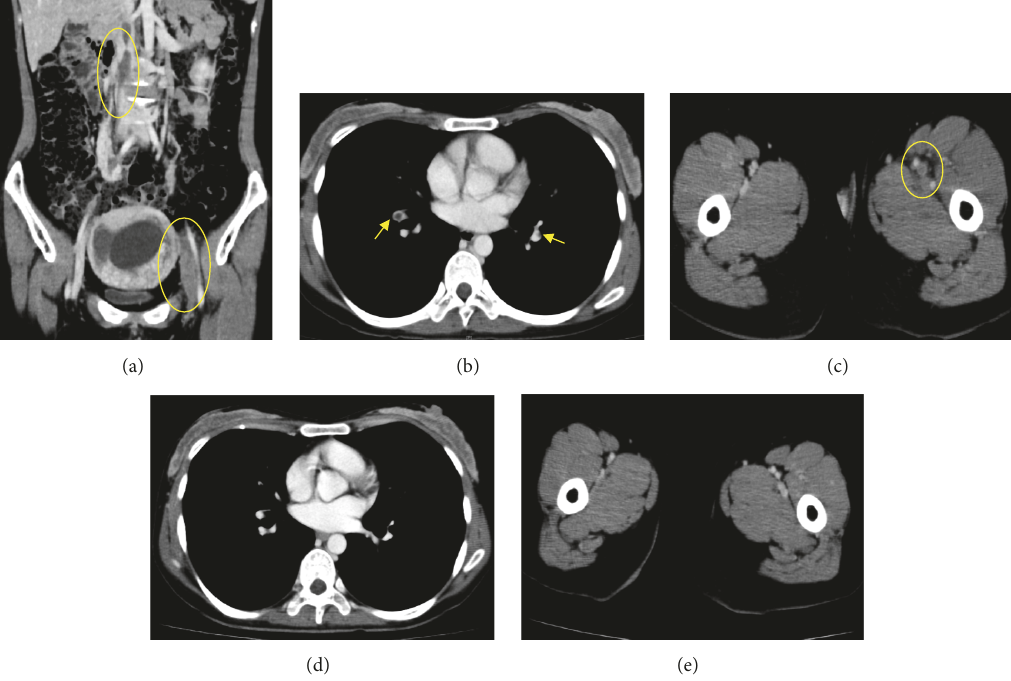
Figure 1: Development of severe VTE, and its disappearance after treatment at patient’s fourth pregnancy. (a ∼ c) Contrast CT image taken at the admission day. (a) Coronal plane, large thrombosis exists in inferior vena cava and femoral vein. (b) Transverse plane at the level of trunk of pulmonary artery. (c) Transverse plane at the level of femoral vein. Yellow circle and arrow indicate the location of venous thrombosis. (d, e) Contrast CT image taken at the start of oral administration of edoxaban. (d) Transverse plane at the level of trunk of pulmonary artery. (e) Transverse plane at the level of femoral